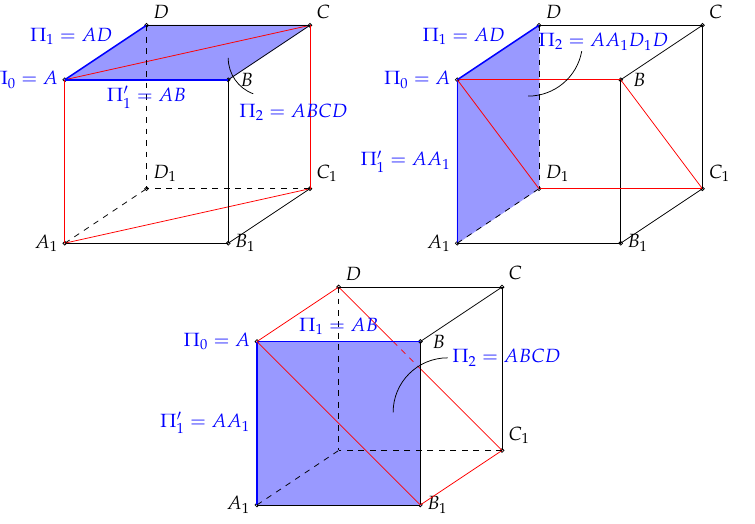
Figure 2. Flags at A in the real